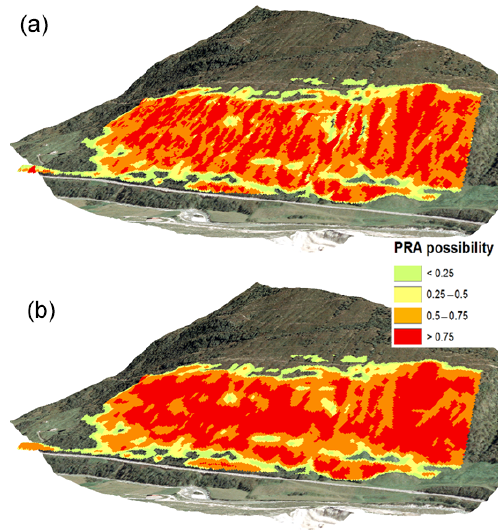
Figure 14. PRA possibility of a snow depth of (a) 1.2m and (b) 2.5m. No specific wind direction is set.